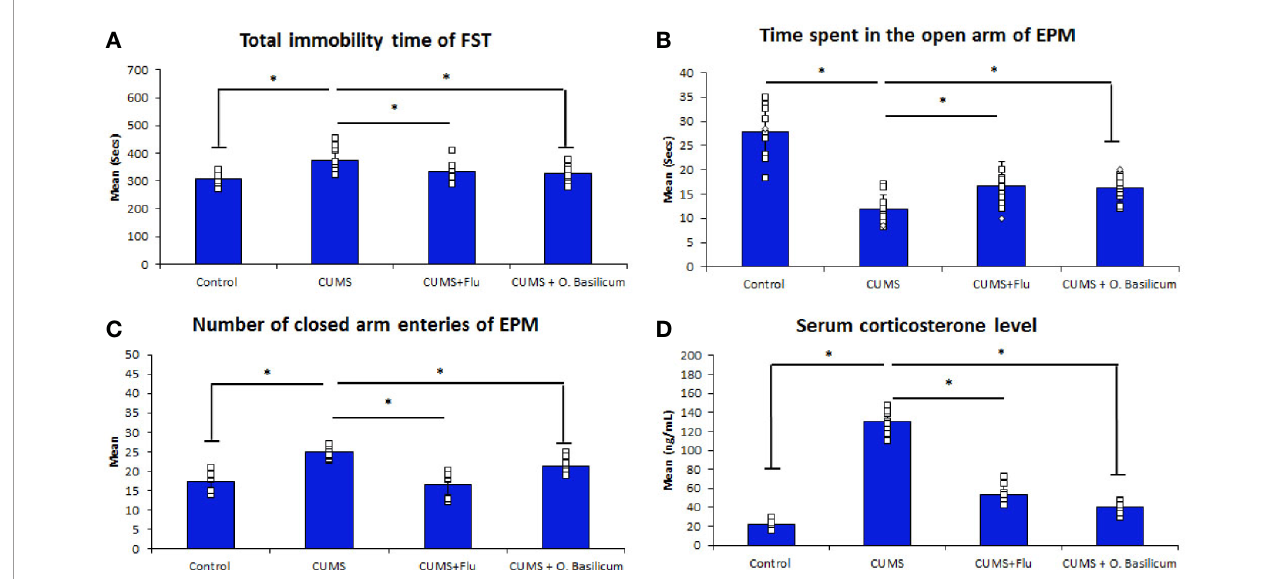
FIGURE 1 | Effect of Ocimum basilicum on the immobility time of the forced swimming test (FST) (A) , the time spent in the open arm (B) , the number of closed arm entries (C) of the elevated plus maise (EPM) test, and serum corticosterone level (D) . Data are expressed as mean ± SD (n = 10). * signi fi cance with p < 0.05. CUMS, chronic unpredictable mild stress; FLU fl uoxetine; O. basilicum , Ocimum basilicum